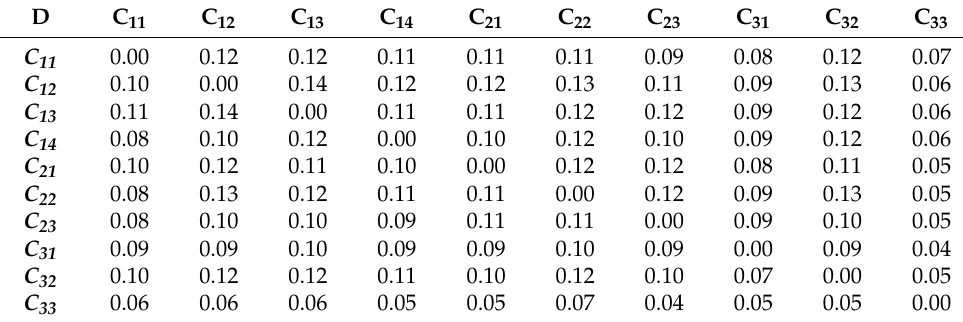
Table 3. Normalized average direct influence relation matrix N